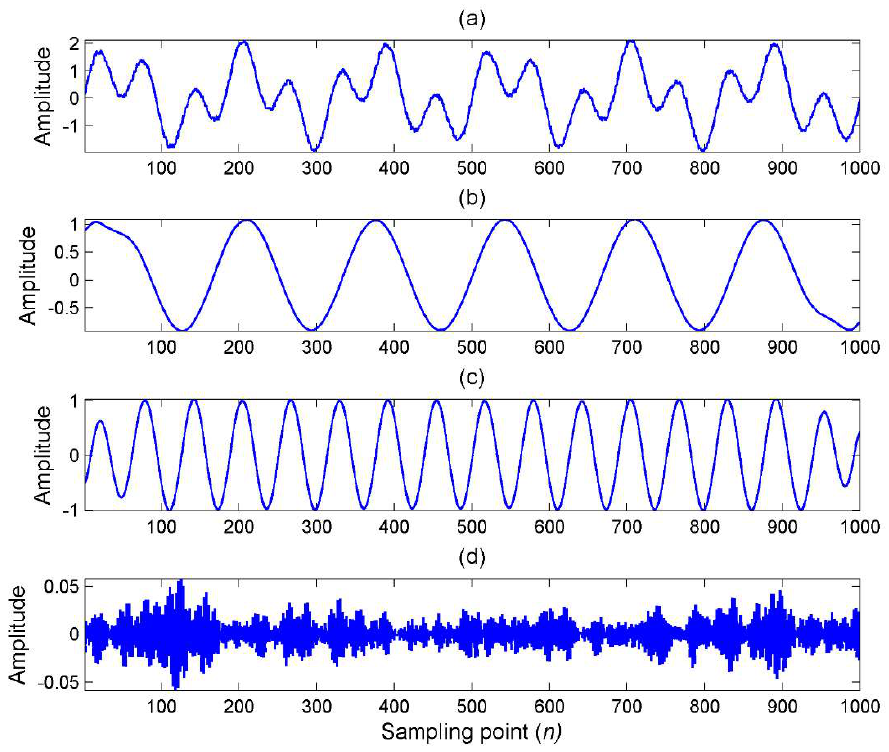
Figure 5. Decomposition of the artificially mixed signal with 20% additive noise by VMD: ( a ) the signal; ( b ) IMF1 of the signal; ( c ) IMF2 of the signal; ( d ) IMF3 of the signal.